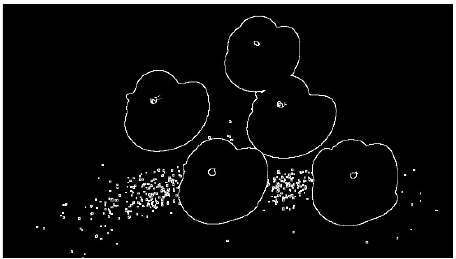
Figure 9. Result of edge extraction for the original gray image.